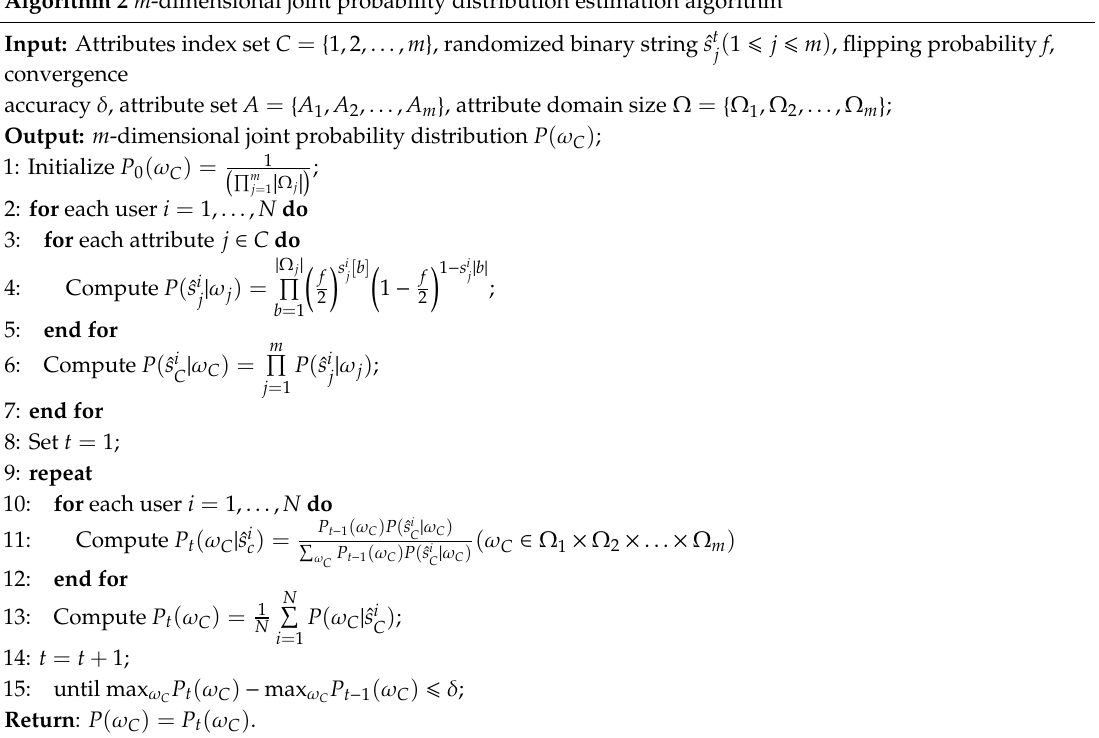
Algorithm 2 m -dimensional joint probability distribution estimation